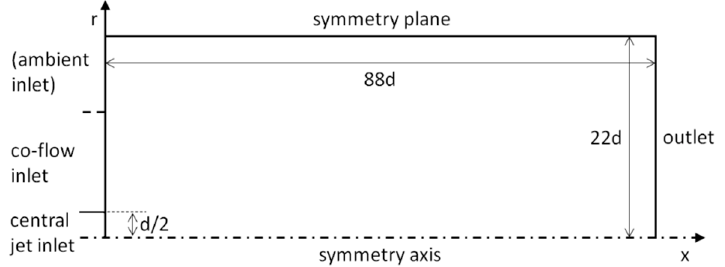
Figure 3. Sketch of solution domain (not to scale).